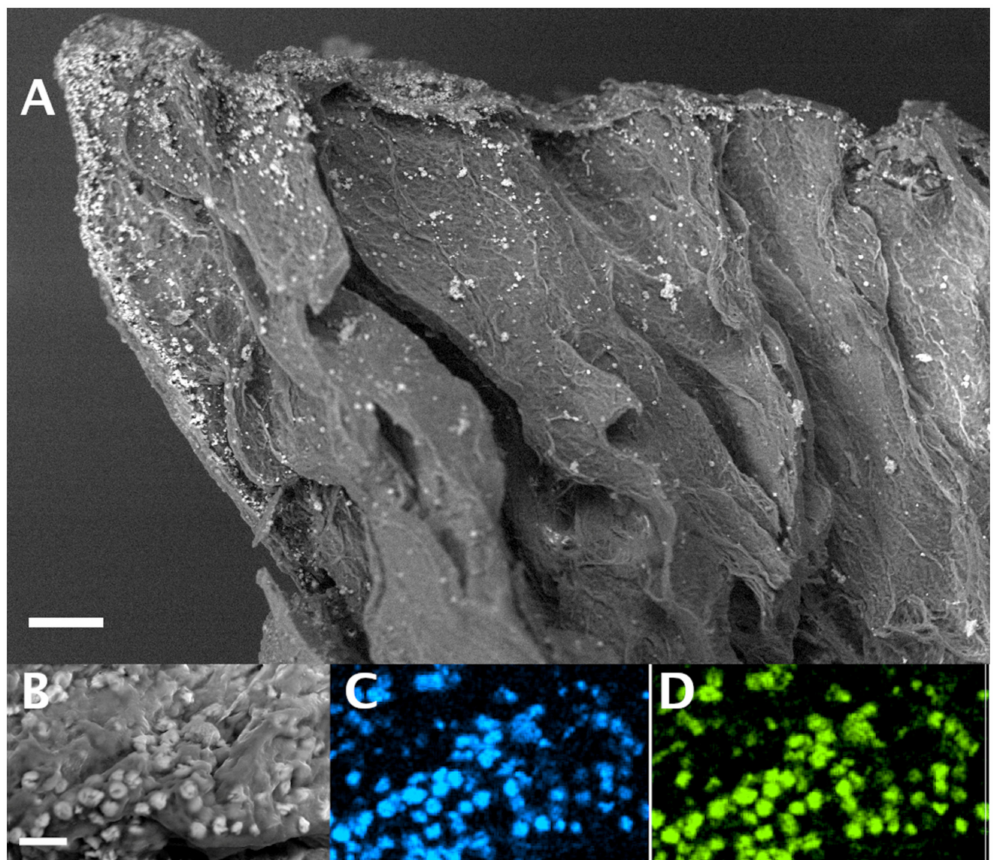
Figure 6. Micrographs of mineralized hybrid hydrogel by SEM. ( A ) The longitudinal section and the upper face of the polymeric scaffold. The surface is decorated by bright micrometric particles indicating the mineralization process. ( B ) Detailed SEM image and EDX spectrum images of the distribution of calcium ( C ) and phosphorus ( D ) over the scaffold G-PEG-Dx2 surface with OM hPL. Scale bars: 100 µ m for the upper panel, 20 µ m for the lower